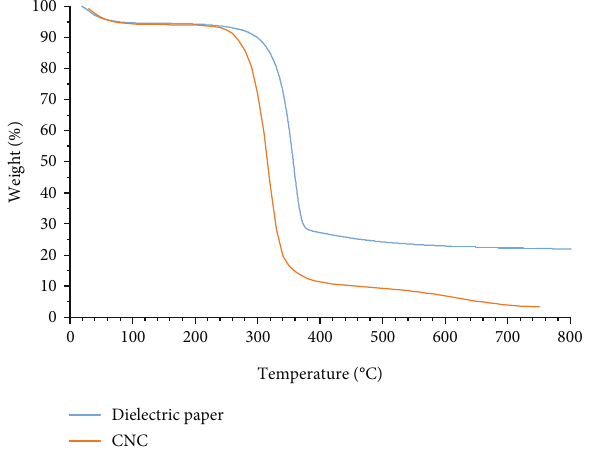
Figure 8: TGA curve of cellulosic